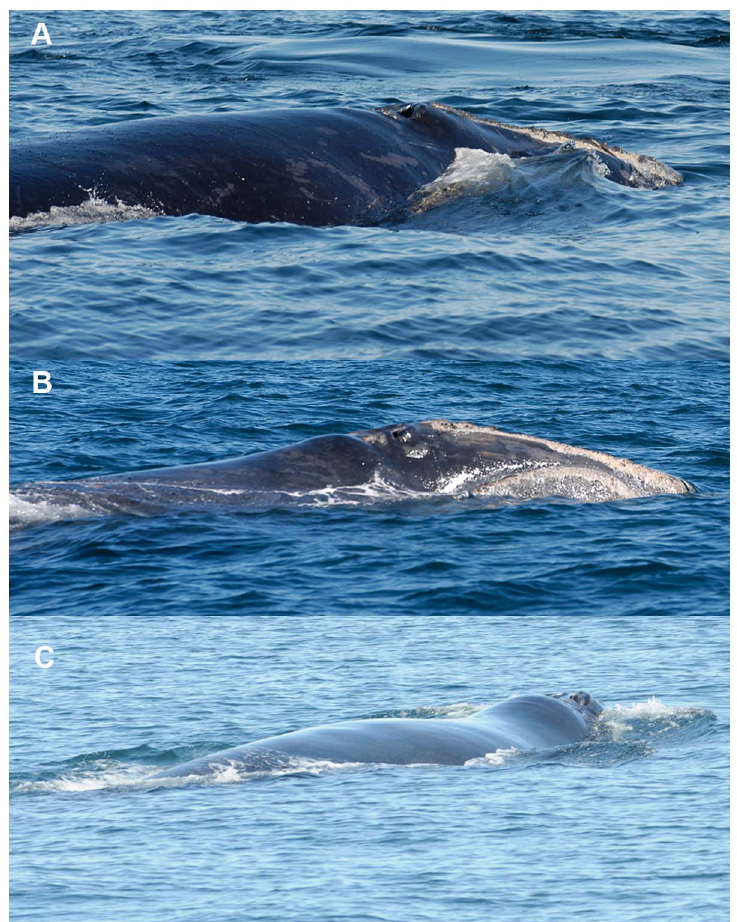
Figure 2. Body condition photos. Plate showing examples of the different classes of body condition judged by the evaluation of the dorsal back profile in the post-blowhole region: a) good, b) fair, and c) poor. Note the contrast between the level to convex nuchal area in a) and the concavity where the back drops off behind a pronounced hump in c). Photographs were taken under permits from the National Marine Fisheries Service ( # 15415) and the Department of Fisheries and Oceans, Canada. Photo credit: New England Aquarium.